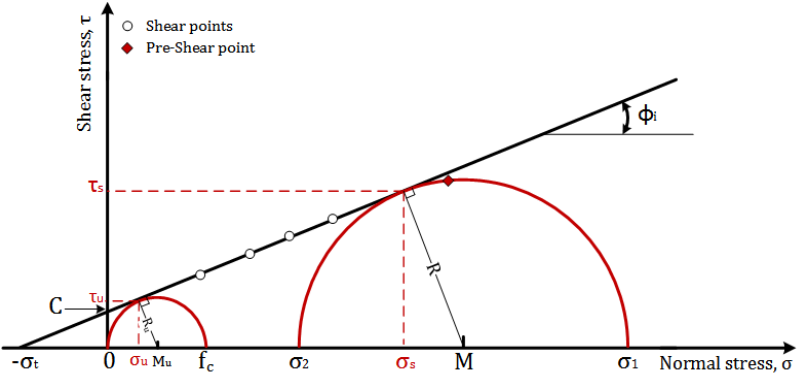
Figure 1. General linear YL and flow properties for a Coulomb material.